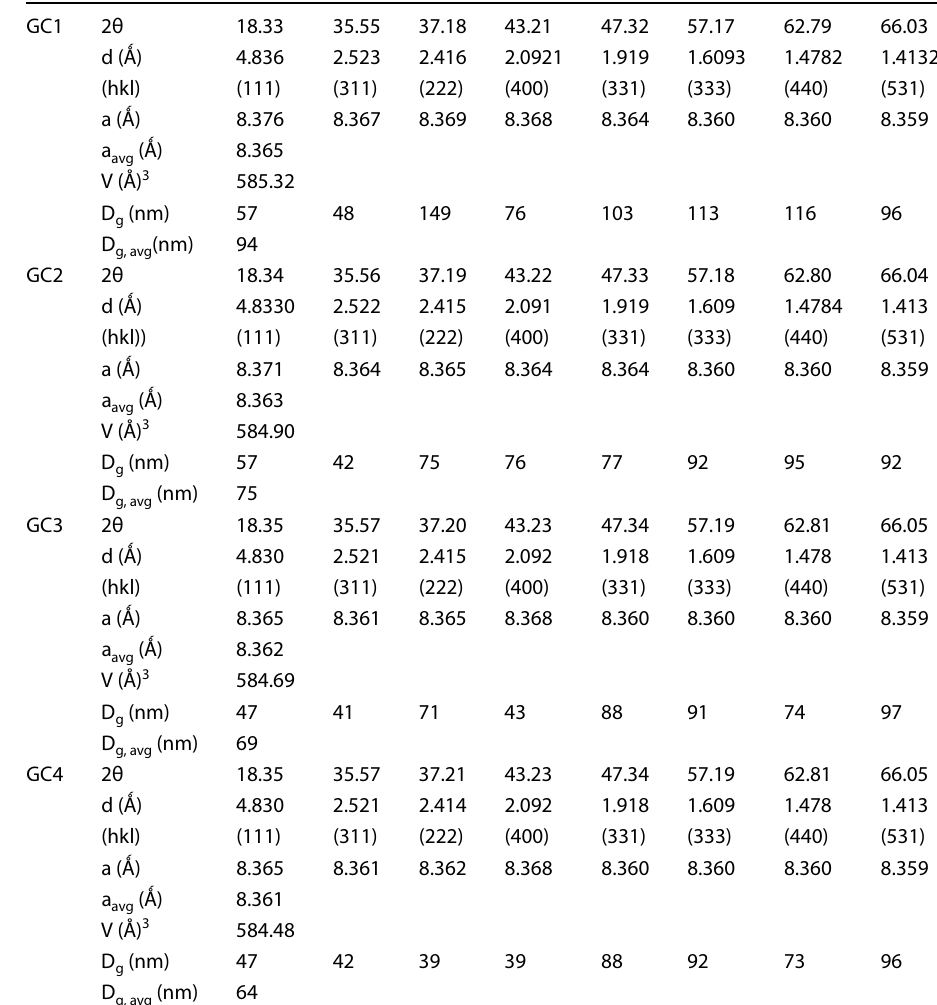
Table 4 Position of the X-ray peaks, interplanar spacing, corresponding miller indices and calculated lattice constant of the LTO